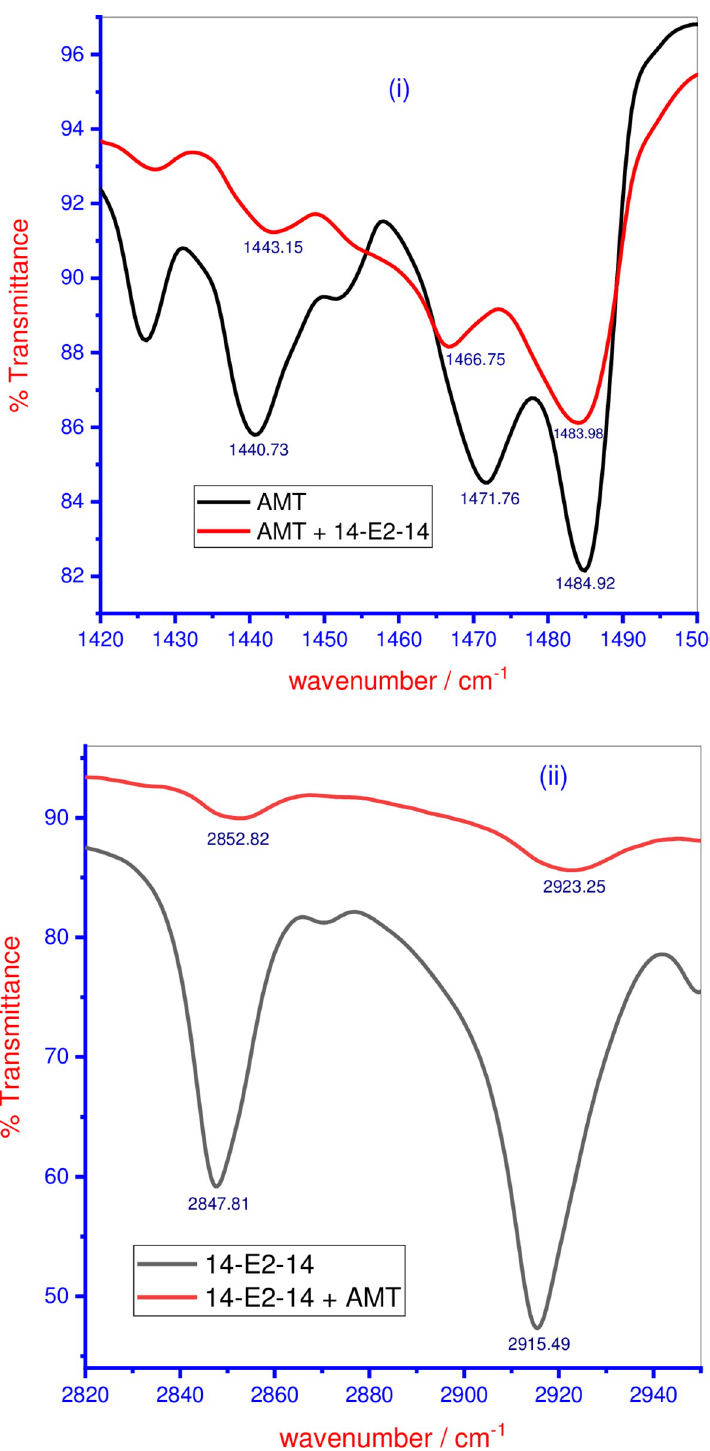
Fig 3. FTIR spectra of (i) AMT in absence and presence of 14-E2-14 and (ii) 14-E2-14 in absence and presence of AMT (both mixtures are in equal ratio).